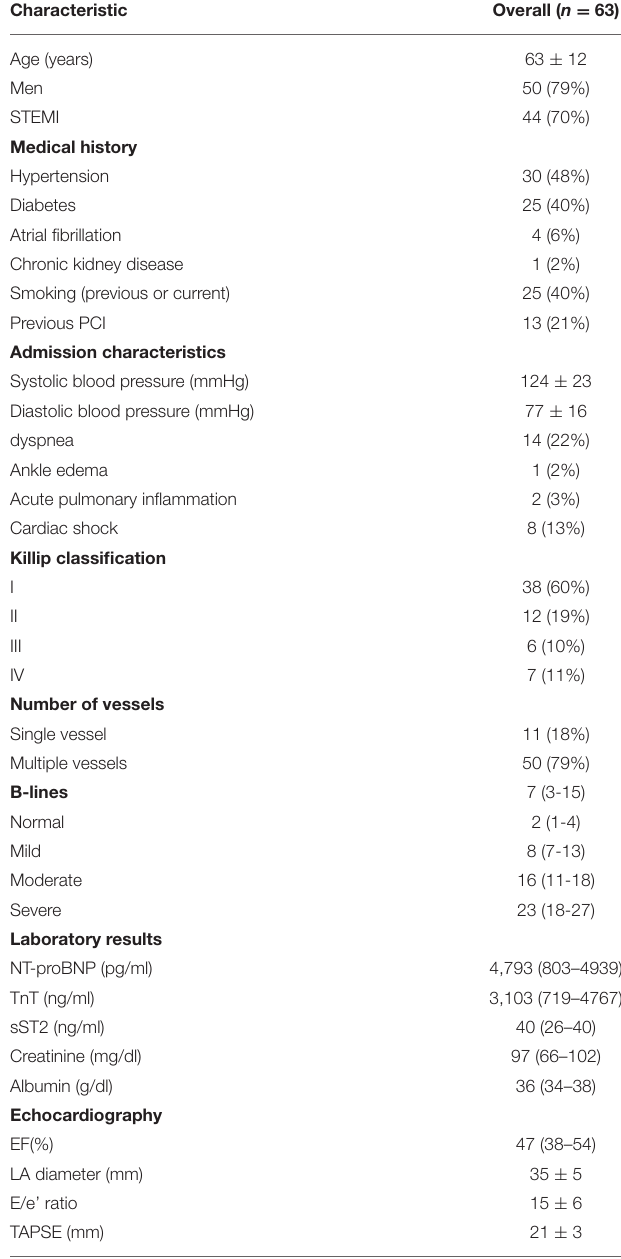
TABLE 1 | Patient characteristics ( N =